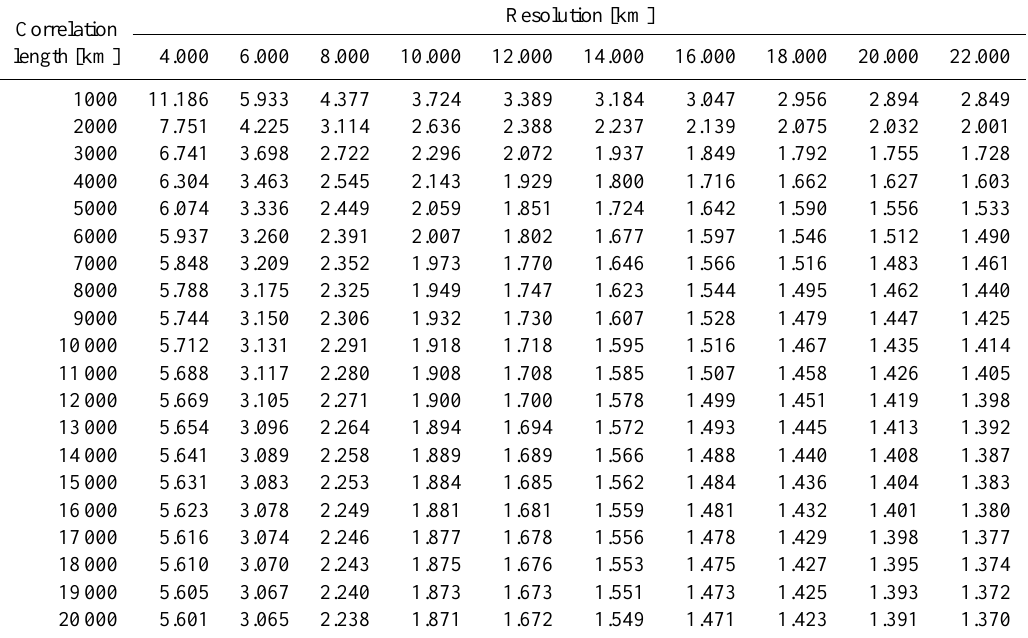
Table 1. Ratio of correctly calculated smoothing errors and smoothing errors calculated via Gaussian error propagation.